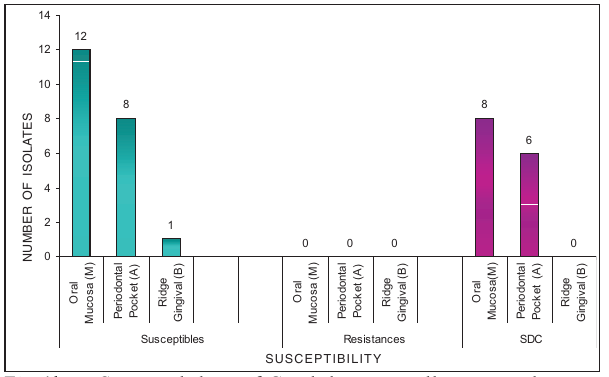
Fig. 2b - Susceptibility of Candida non- albicans isolates to Ketoconazole for sites collected.